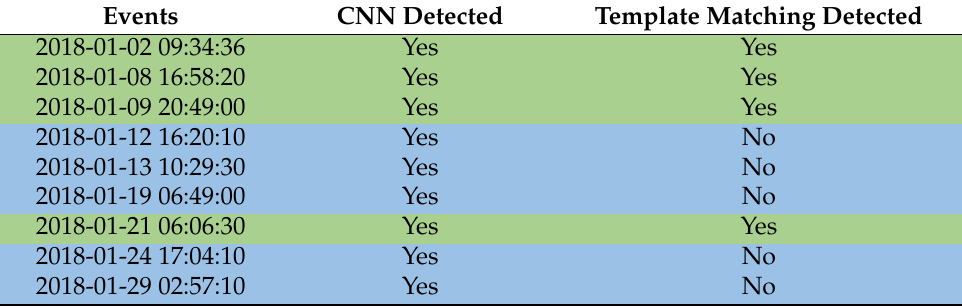
Table 3. Cont. Events CNN